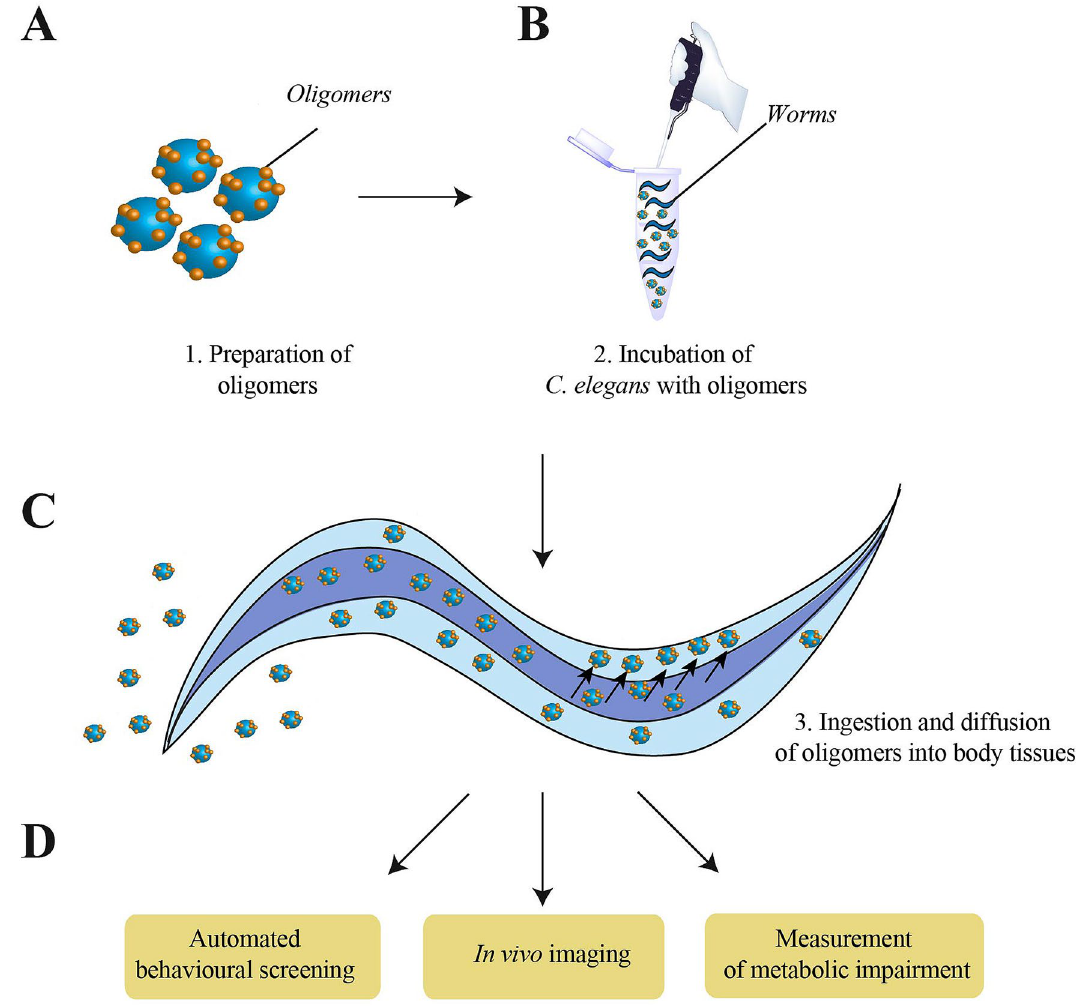
Figure 1. Schematic description of the protocol to probe the effects of exposure of C. elegans to misfolded protein oligomers. ( A ) Oligomers were formed as described previously 23,24,27 . ( B ) Worms were incubated at day 0 (D0) with the different oligomeric species for 6–12 h. ( C ) Diffusion of labeled oligomers through the intestinal barrier was monitored through confocal microscopy. ( D ) High-throughput strategies were used to screen for worm fitness after